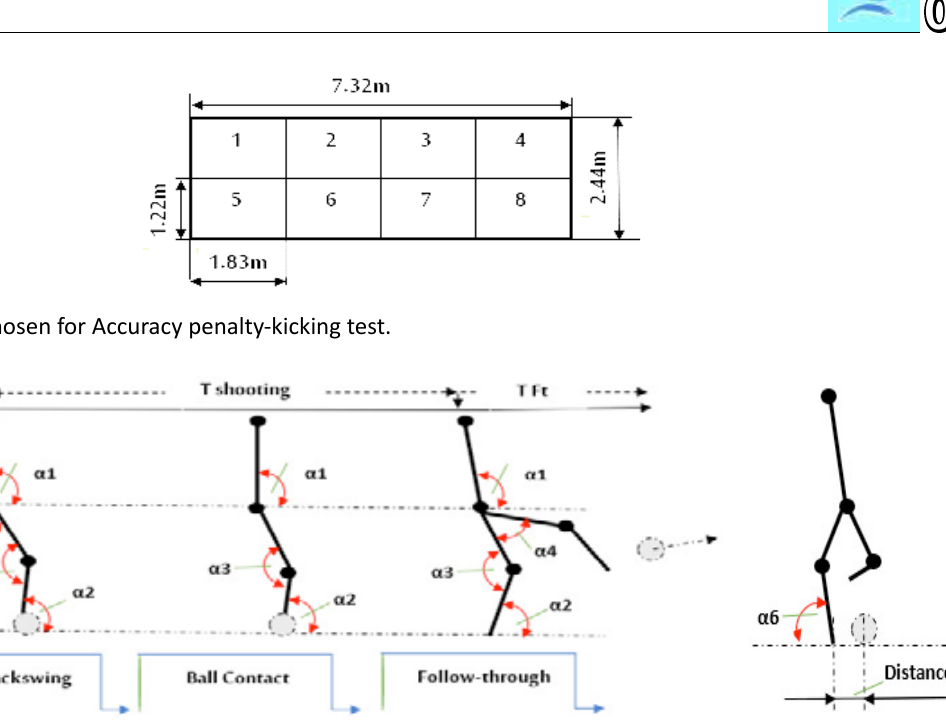
Right Lateral View Posterior View Figure 3. (α1) Trunk° / (α2 Pivot foot) Knee° Pi / (α3) Shank° / (α4) Thighs° / (α5 Shoot foot) Knee° Sh / (α6) Inclination Body° / (Distance m ); Distance Pivot Foot &Ball / (Time s ); T Beginning, T Back Swing, T FootContact, T